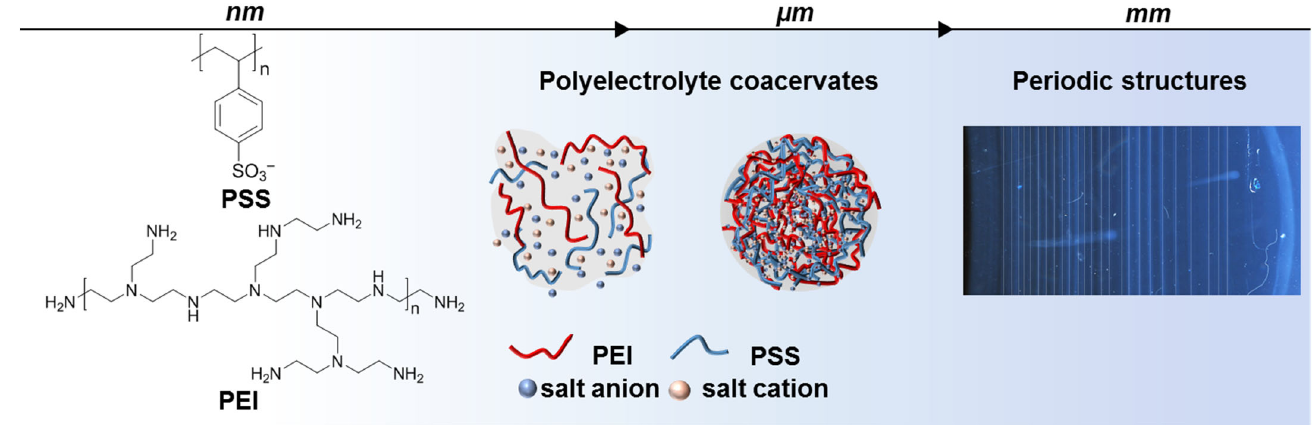
Figure 1. PEC formation at the nano- (nm), micro- ( µ m) and macro- (mm) scale. Three approaches varying the shape of initial boundary between compartments in